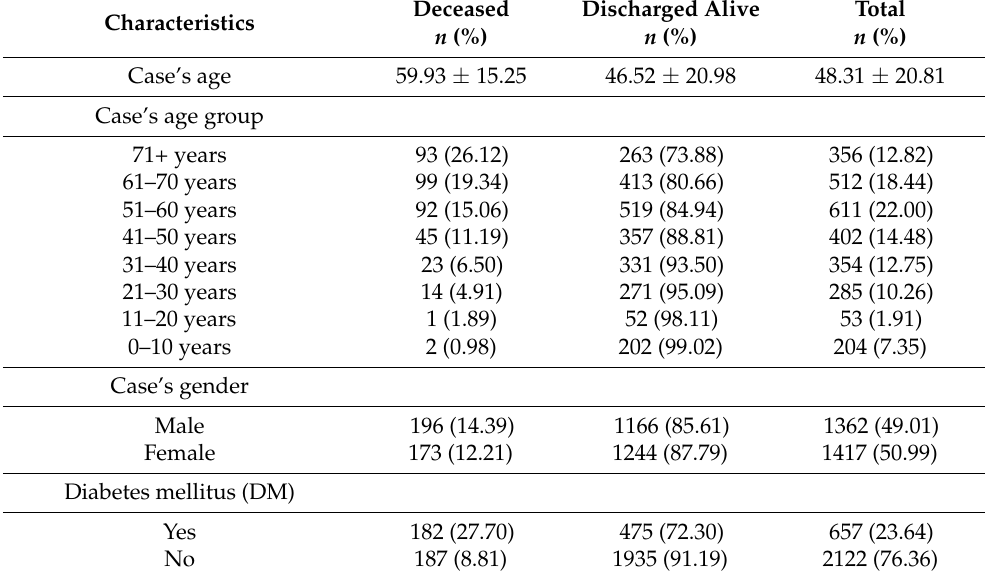
Table 1. Characteristics of study